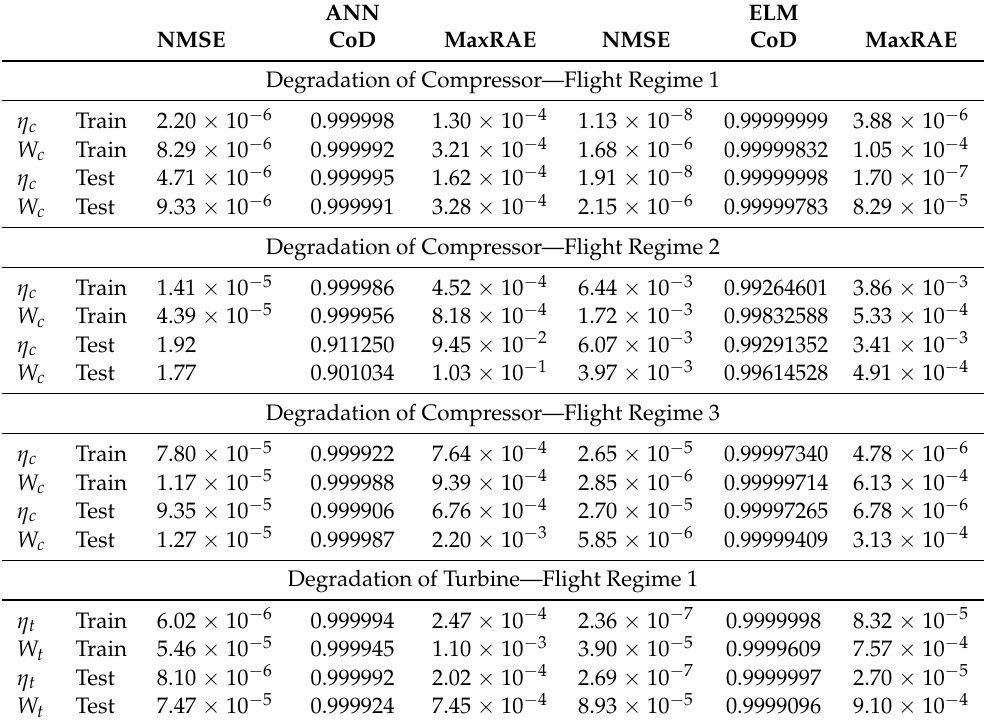
Table 5. Metrics for input vectors 1 and 2 ELM and